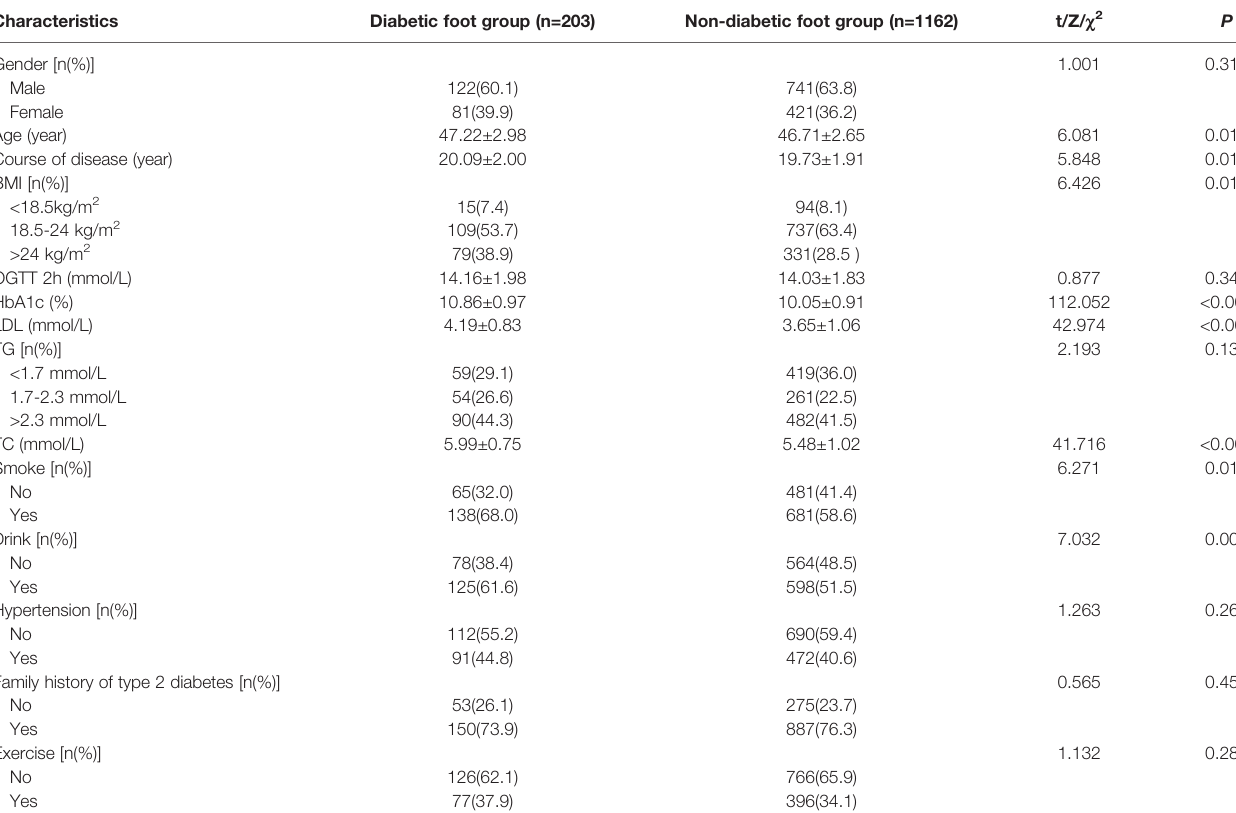
TABLE 2 | Univariate logistic regression analysis of patients in the training cohort. Characteristics